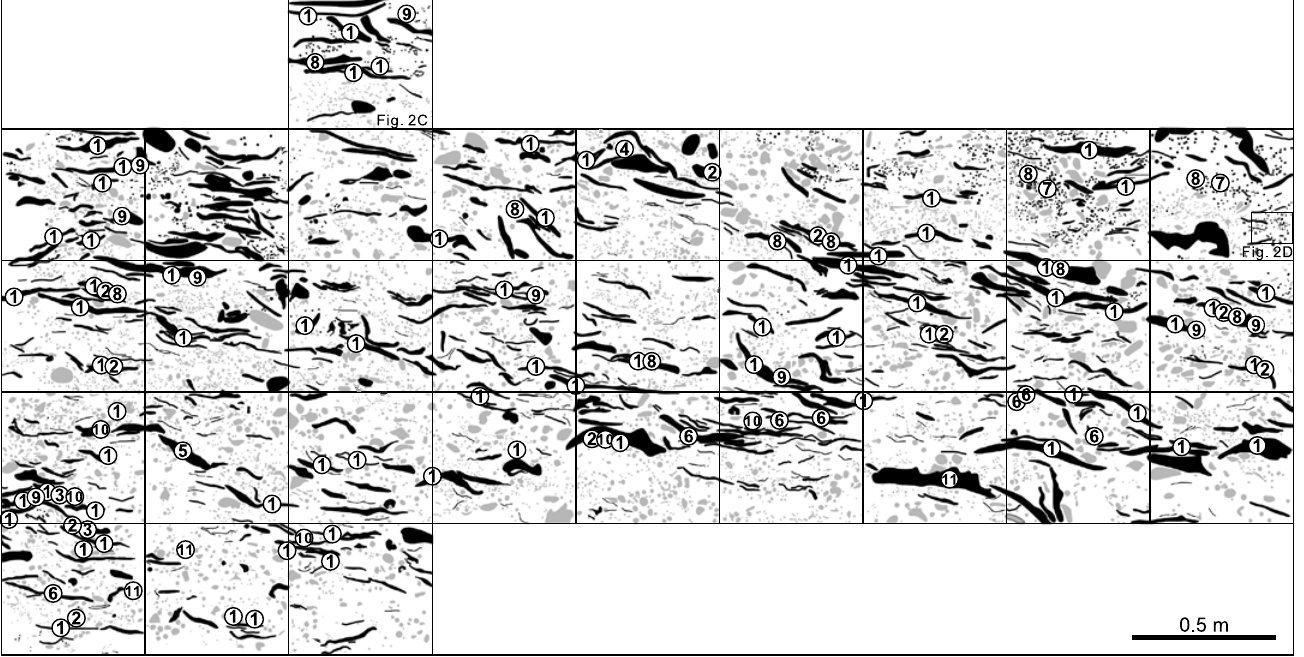
Fig. 3. Schematic vertical section of stromatoporoids in the Jiwozhai reef (Huang et al . 2020) showing the spatial distribution of different stromatoporoids, note the predominance of the Gerronostromaria grossum Dong, 1974, in the laminar form stromatoporoids. 1, Gerronostromaria grossum Dong, 1974; 2, Clathrocoilona spissa (Lecompte, 1951); 3, ? Habrostroma laminosum (Lecompte, 1952); 4, Parallelopora sp.; 5, Pseudotrupetostroma porosum (Yang and Dong, 1979); 6, Salairella buecheliensis (Bargatzky, 1881); 7, Stachyodes costulata Lecompte, 1952; 8, Stachyodes fasciculata Dong in Dong et al., 1989; 9, Stachyodes sp.; 10, Stictostroma saginatum (Lecompte, 1951); 11, Synthetostroma actinostromoides Lecompte, 1951. Black, stromatoporoids; gray, other organisms between